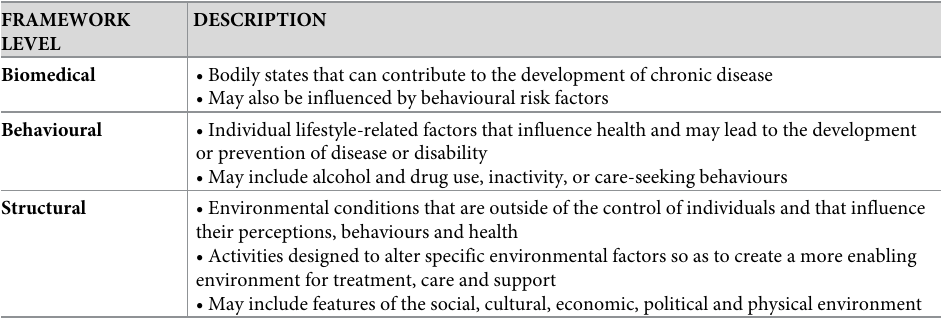
Table 1. Risk and vulnerability framework levels